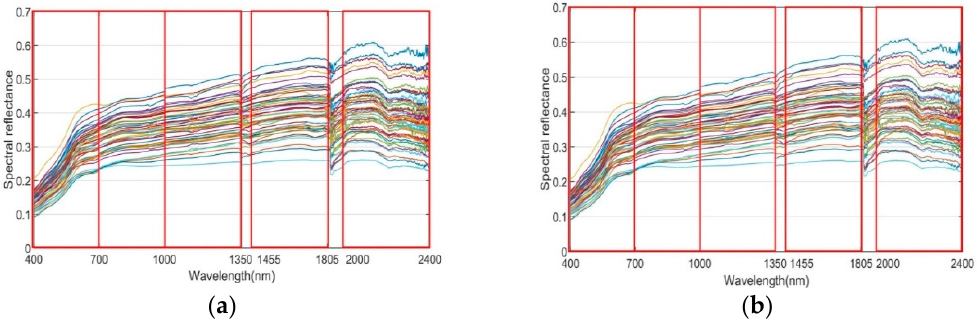
Figure 6. Wave band data: ( a ) from the raw spectra; and ( b ) after Savitzky ‐ Golay (SG) smoothing.